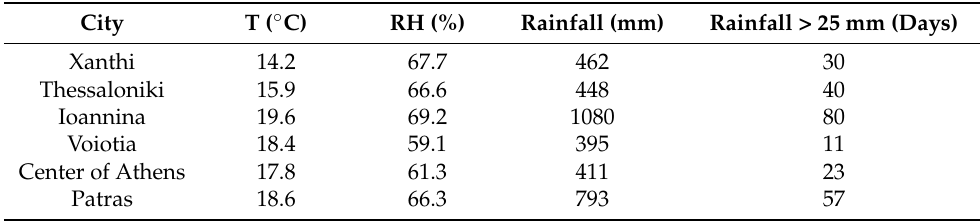
Table 13. Average annual temperature (T), relative humidity (RH), annual rainfall (mm) and rainfall higher than 25 mm (days) in exposure areas [48].